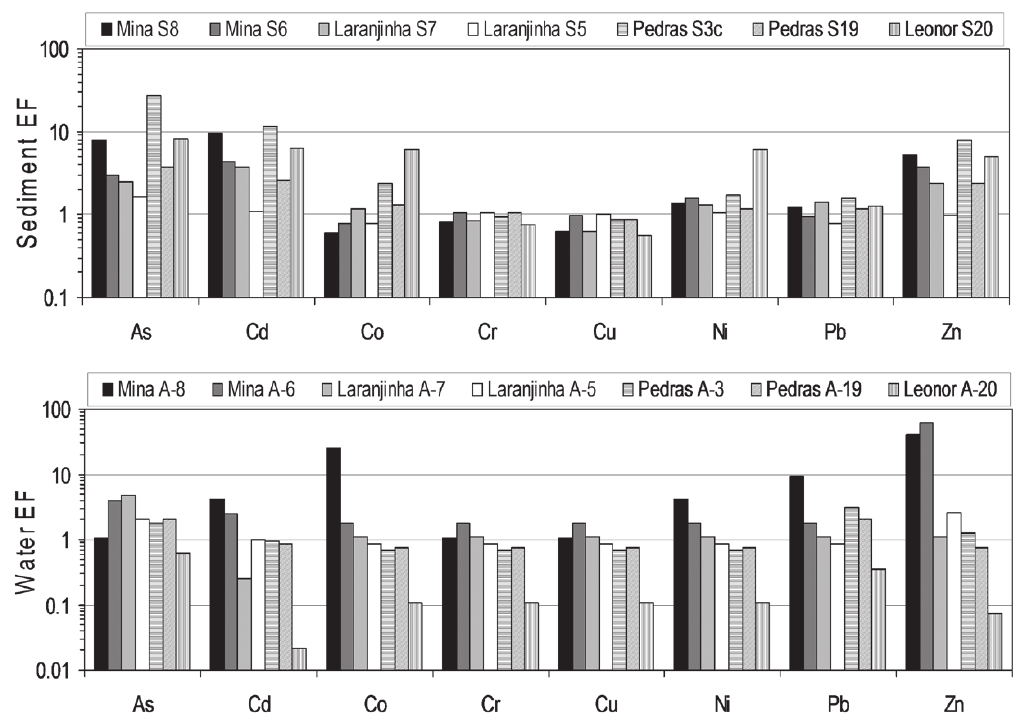
Figure 4 - Comparison of water enrichment factors (normalized to Cl − ) and sediment enrichment factors (normalized to Al) obtained for the same sampling stations located at the Mina, Pedras and Leonor streams and the Laranjinha